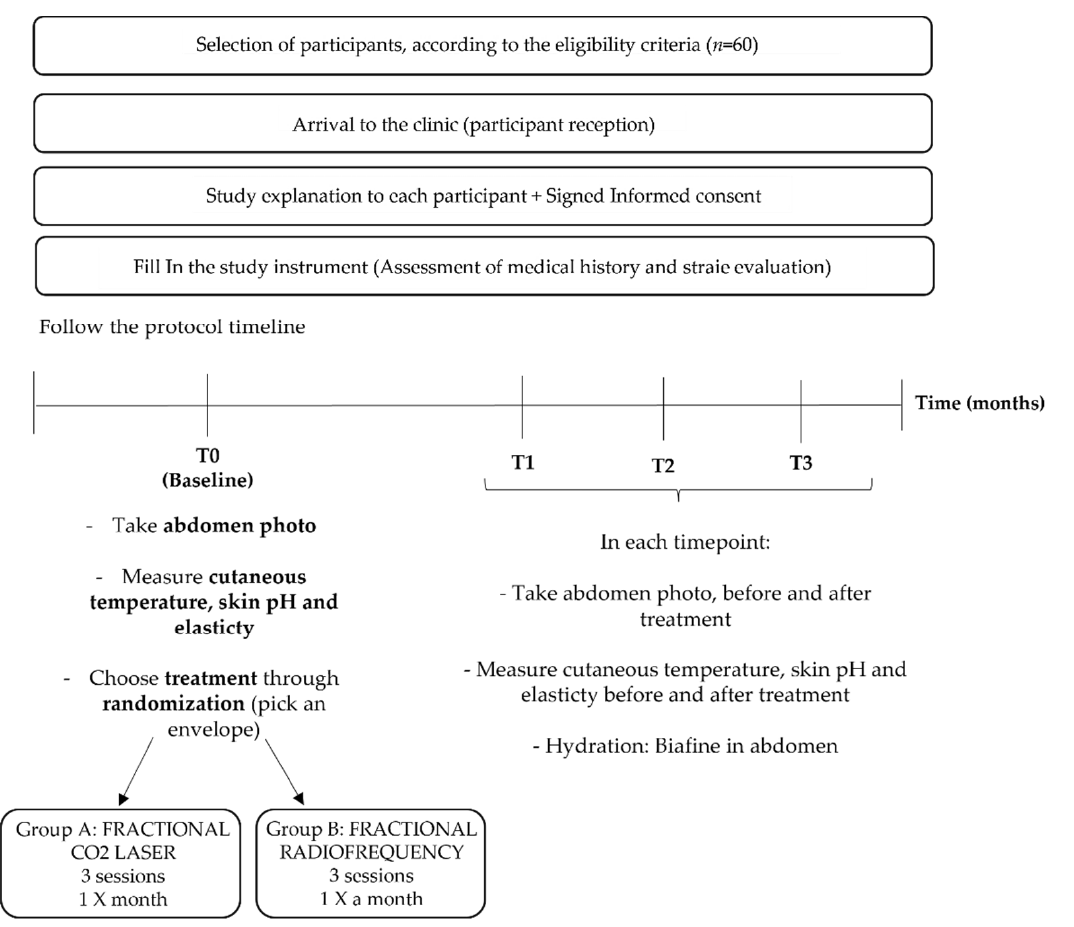
Figure 1. Trial Flow Chart .